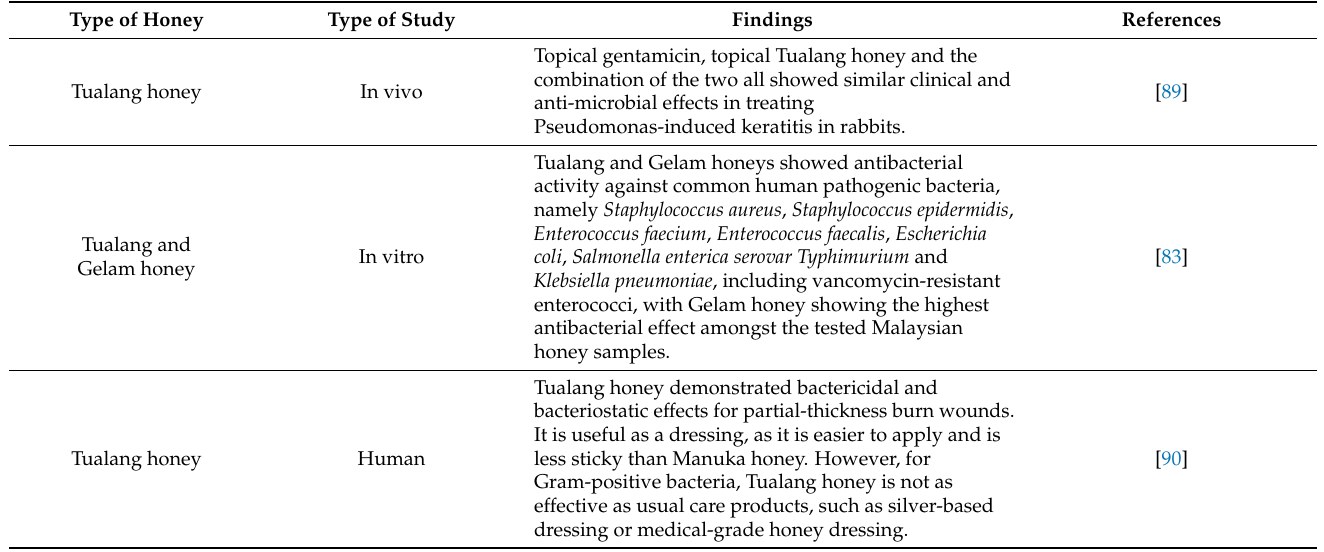
Table 5. Summary of anti-microbial